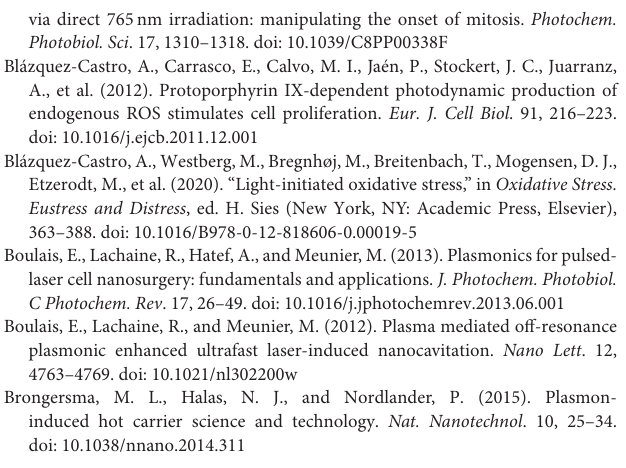
FIGURE 2 | (b–f) cw 514nm Ar-ion laser irradiation showing examples of the damage to the endosomes; (b–d) dissolution of the membrane of endosomes filled with fewer particles (red arrows) while endosomes filled with more particles tend to remain intact or suffer only minor damage (blue arrows); (e,f) escape of nanoparticles into the cytosol after laser-induced rupture of the endosomal membrane. Laser power density and exposure time: (b) 6 Wcm − 2 , 7min; (c,f) 20 Wcm − 2 , 1min; (d) 20 Wcm − 2 , 2min; (e) 6 Wcm − 2 , 3min. Scale bars are 500nm. Reprinted with permission from Krpeti´c et al. (2010). Copyright 2010 American Chemical